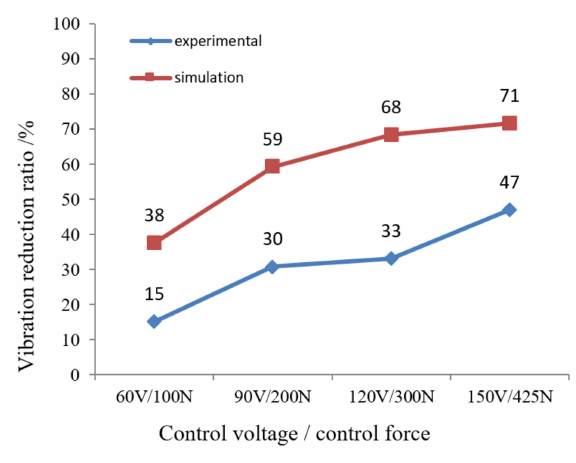
Figure 15. Vibration reduction rate of shafting under di ff erent control voltages /